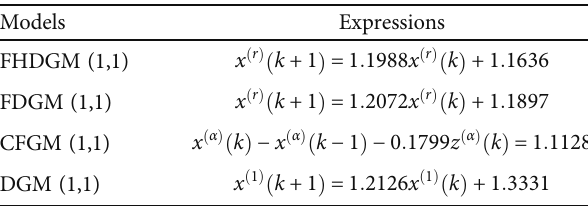
Table 6: The expression of four grey